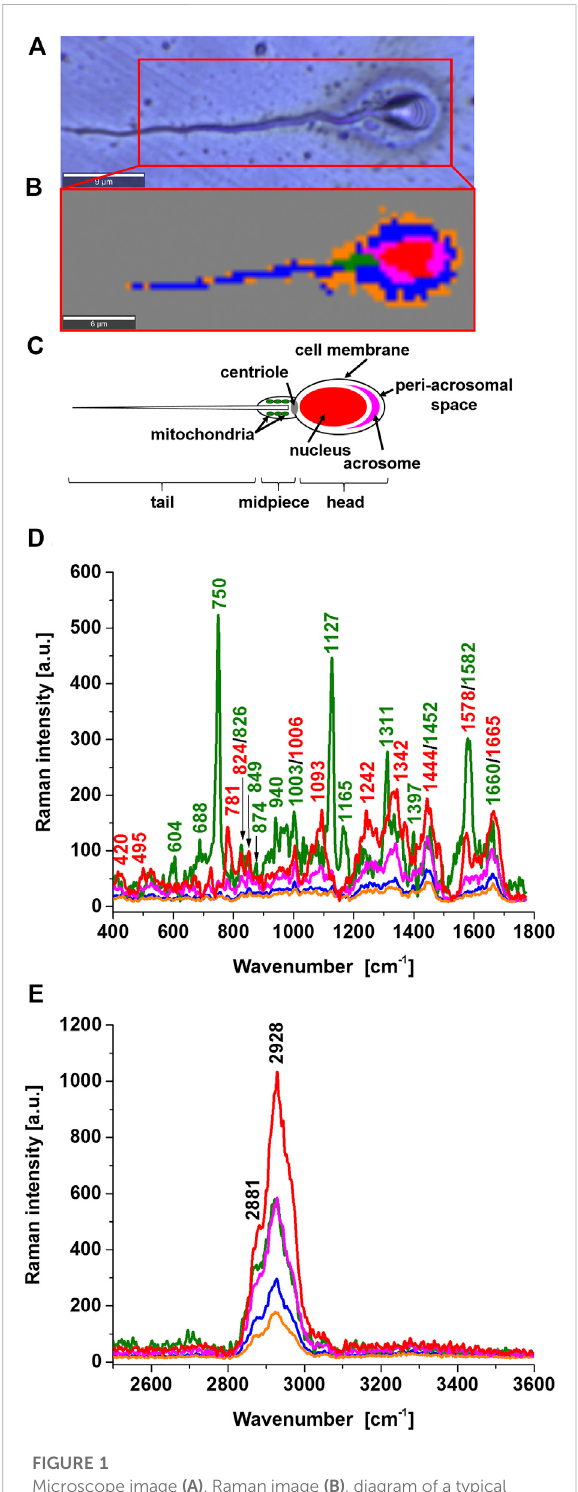
FIGURE 1 Microscope image (A) , Raman image (B) , diagram of a typical human sperm cell (C) , Raman spectra of a typical sperm cell regions: nucleus (red), mitochondrion (green), acrosome (magenta), axsoneme and membrane cell (blue), seminal plasma attached to the surface of the sperm cell (orange) in the fi ngerprint region (D) and high-frequency region (E)